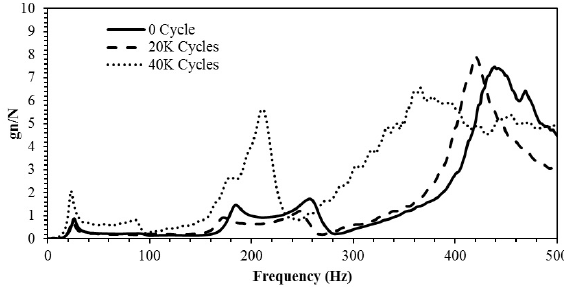
Fig. 11. Comparison of FRF Plots of H2 Beam after 20 000 cycles and 40 000